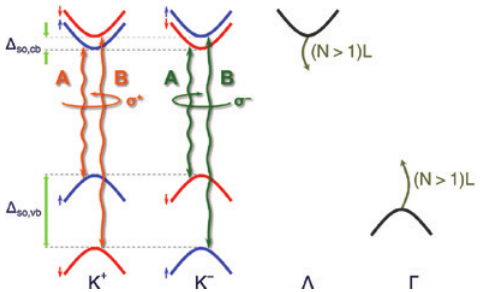
Figure 1: Diagram of subbands in the conduction and valence bands at the K + , K − , Λ , and Γ points of the Brillouin zone in monolayer MoSe . 2 The blue (red) curves indicate the spin-up (spin-down) subbands, while the grey ones illustrate bands without the spin projection. The orange and green wavy lines show the A and B transitions associ- ated with the σ + and σ − polarizations, respectively. Δ denote the corresponding spin-orbit splitting in the conduction and valence